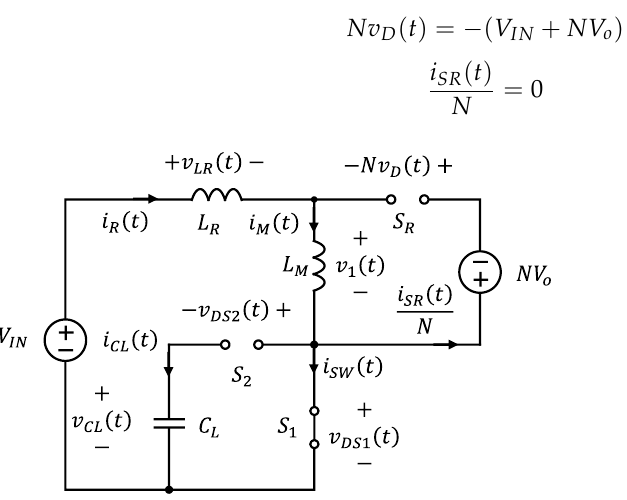
Figure 6. Equivalent circuit in state 1.